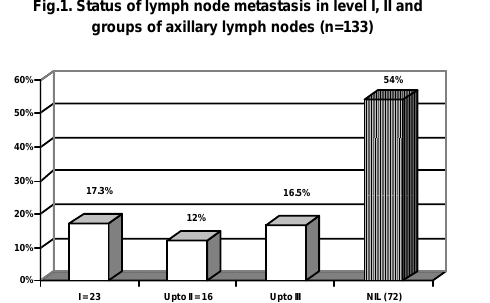
Fig.1. Status of lymph node metastasis in level I, II and groups of axillary lymph nodes (n=133)